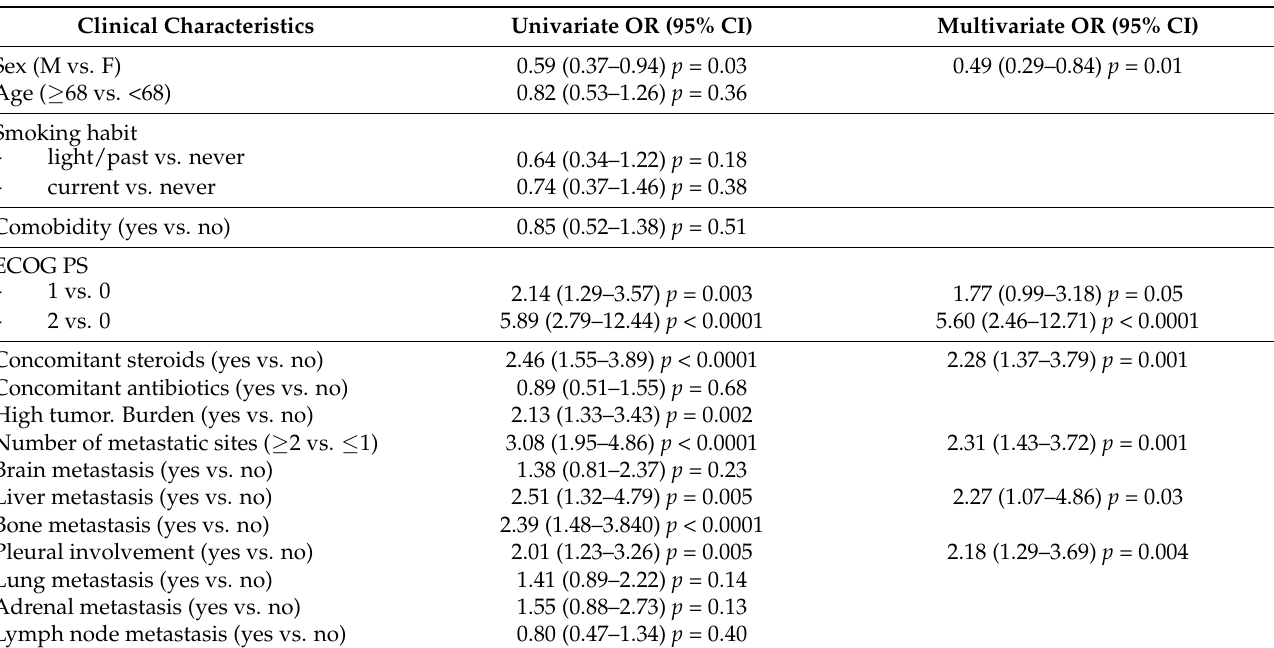
Table 2. Univariate and multivariate logistic regression for the association of clinical characteristics with early progression. Clinical Characteristics